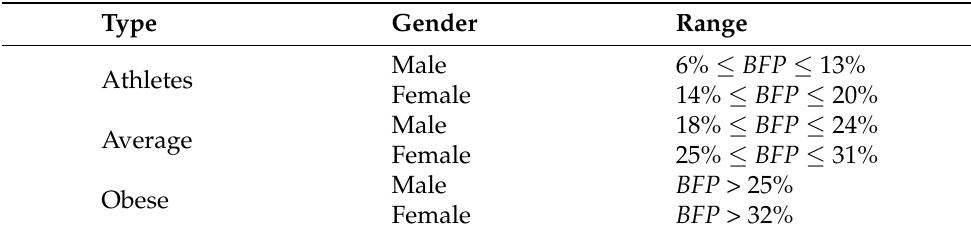
Table 5. Body fat percentage